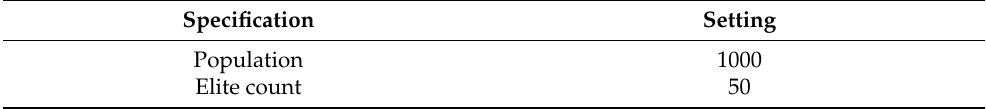
Table 3. Summary of the settings of the genetic algorithm’s specifications.